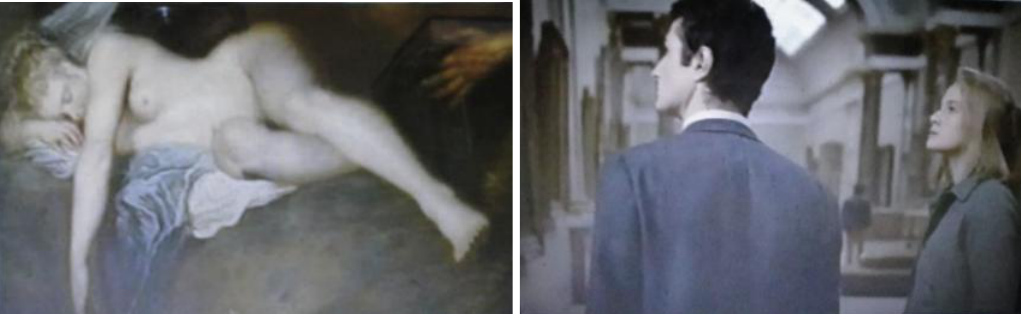
Figure 5: on the right painting Jupiter dévoilant Antiope, by Watteau; on the left, the couple regards the paintings at the Louvre (both shots from Bresson’s A gentle woman